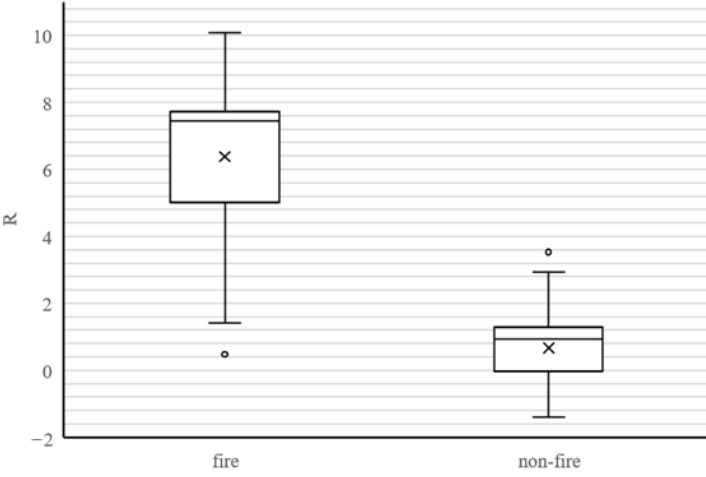
Figure 2. Box-plot of